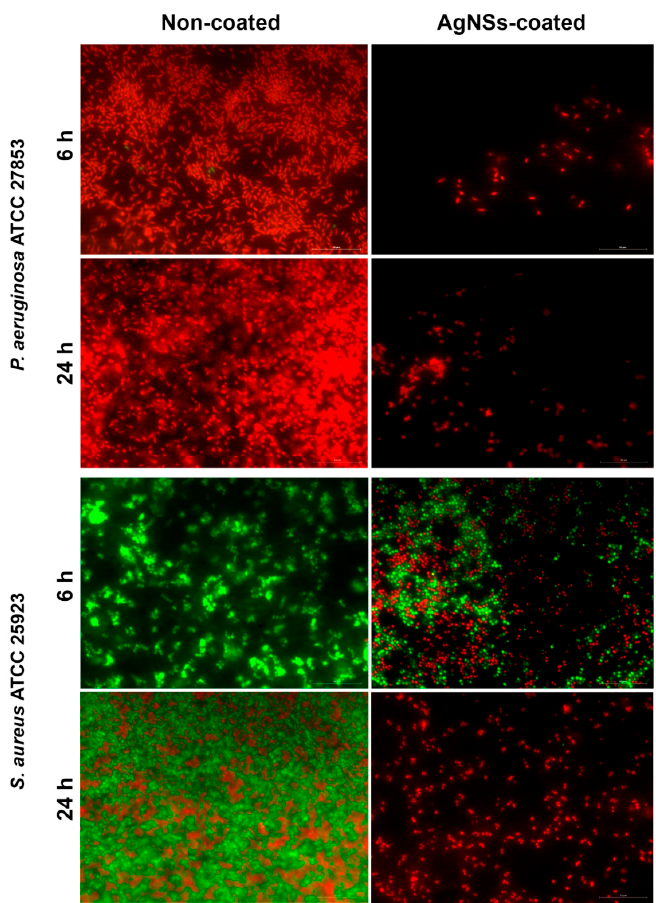
Figure 3. Live/Dead staining images of P. aeruginosa ATCC 27853 and of S. aureus ATCC 25923 Figure 3. Live / Dead staining images of P. aeruginosa ATCC 27853 and of S. aureus ATCC 25923 deposited deposited on non-coated and AgNSs-coated surfaces for 6 and 24 h. on non-coated and AgNSs-coated surfaces for 6 and 24 h.